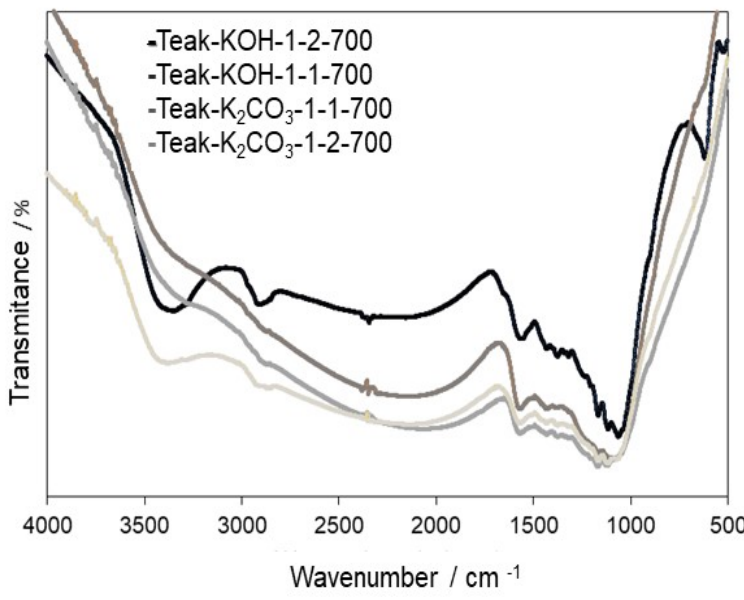
Figure 3. FTIR spectra of ACs prepared from Teak sawdust with KOH and K 2 CO 3 , at 973 K.